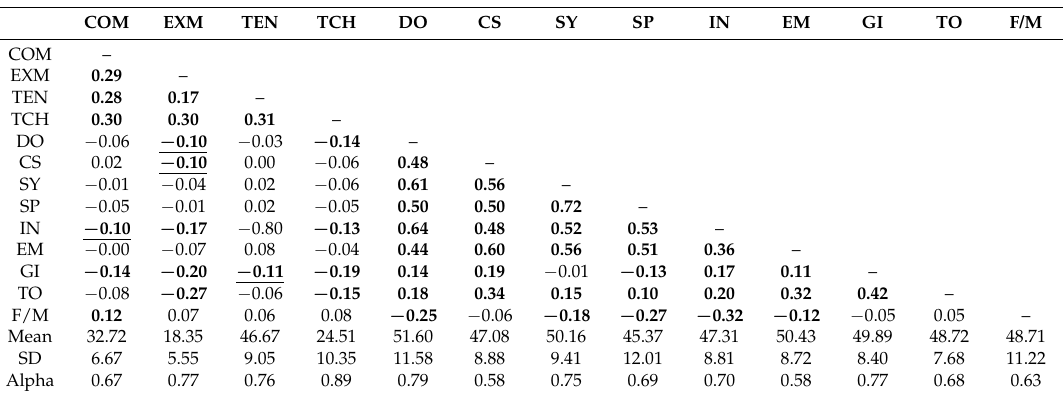
Table 1. Intercorrelations, Means, Standard Deviations, and Reliabilities of the Variables for Religious Doubt and Social Personality